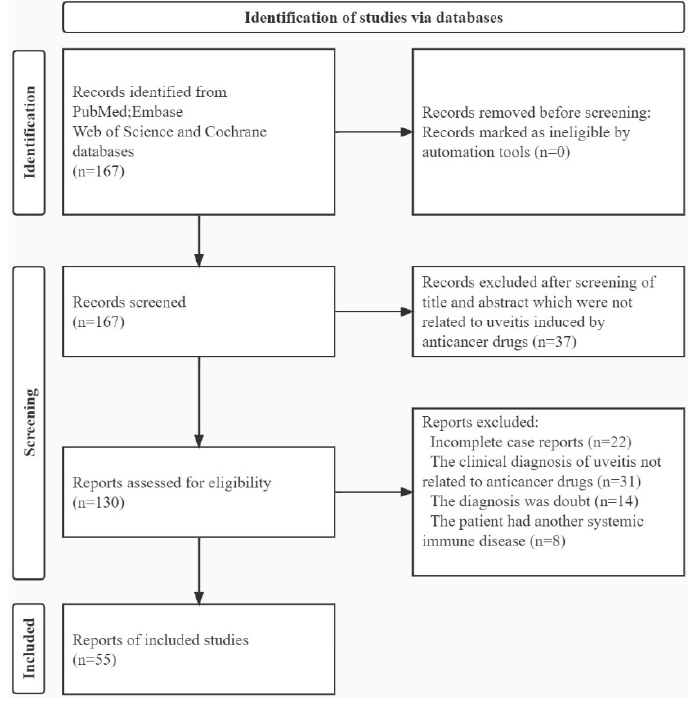
Figure 1. The flowchart for identification of articles in databases.